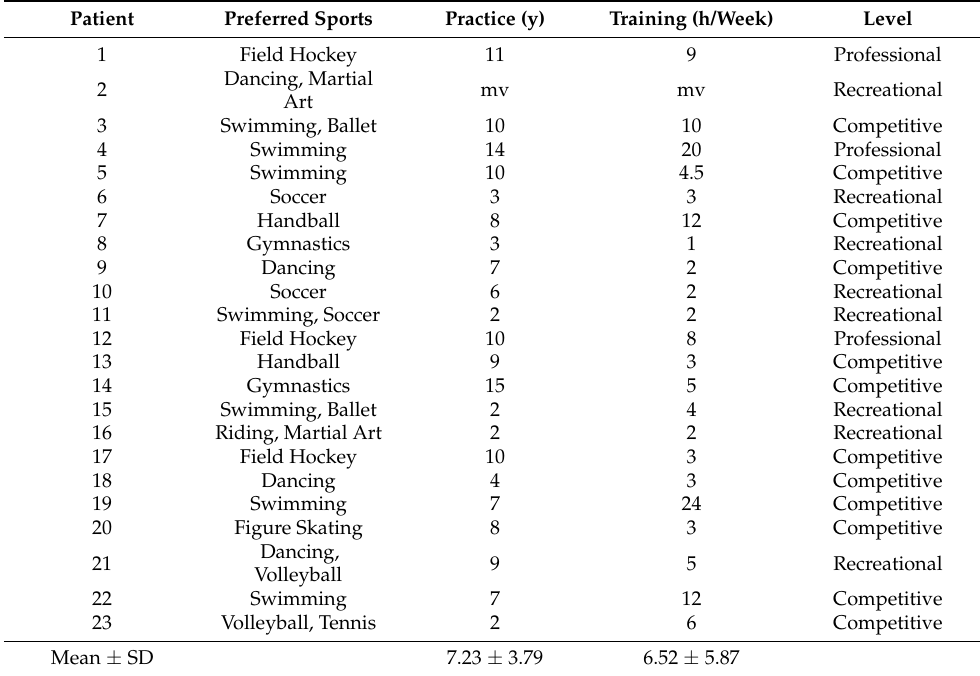
Table 2. Preferred sports activity, intensity and performance level before onset of complaints for every single patient ( n =